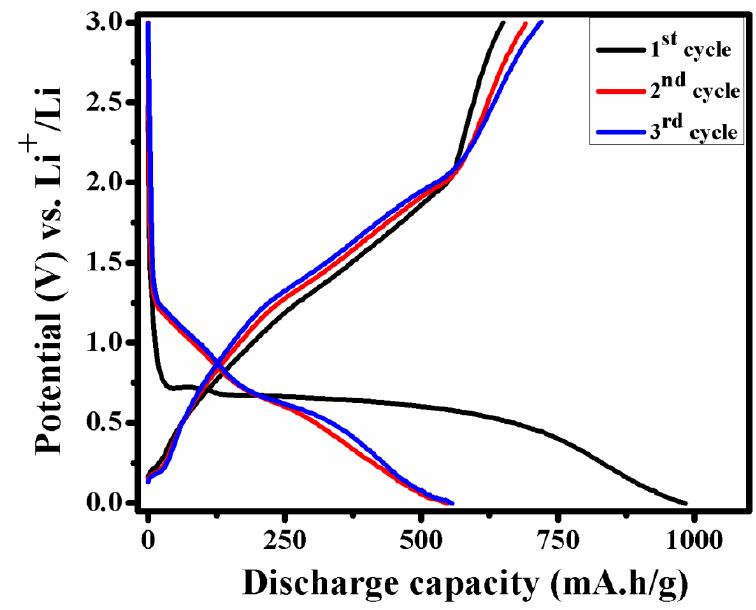
Figure 7. Initial three charge–discharge cycle of NMO at 0.1 A/g. Table 1. Comparison of specific capacities of NiMn 2 O 4 and similar material with the literature. Sr. No.